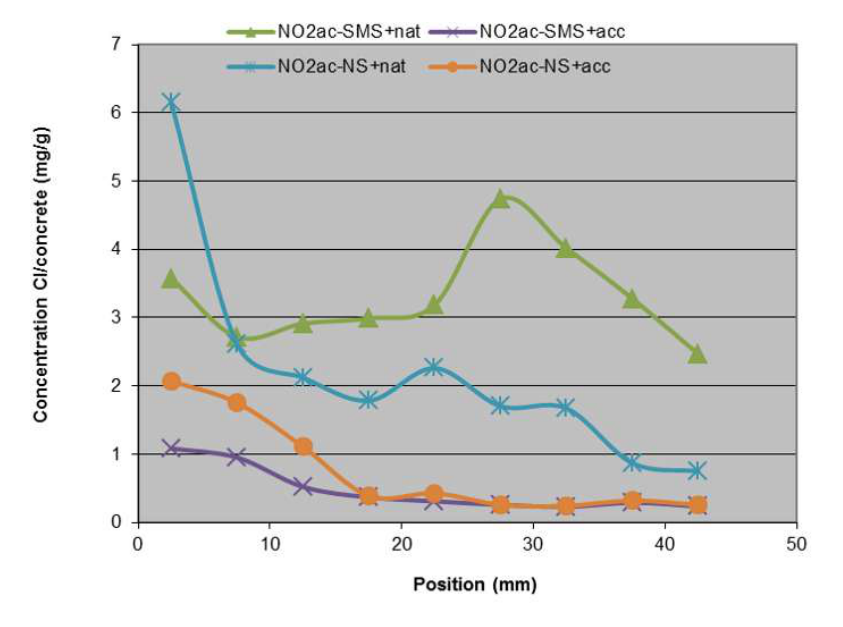
Figure 6. Concentration of chloride ions Normal quality concrete, Natural